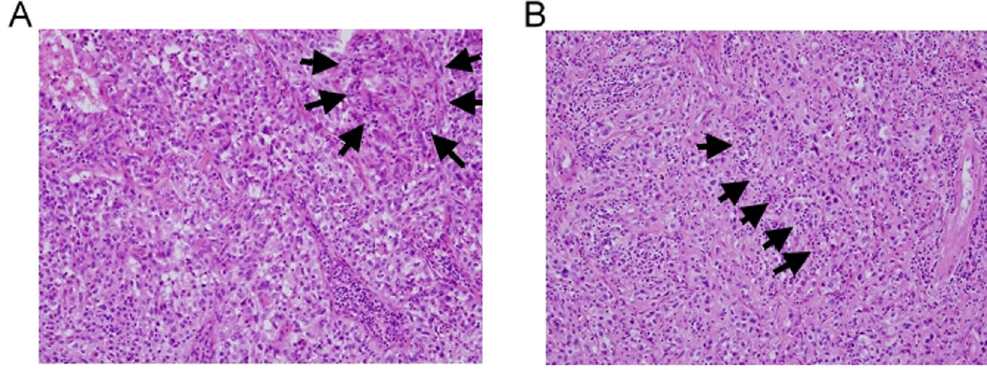
Figure 1. Kaplan-Meier overall survival curve of 259 patients with mUC, stratified by TILs.